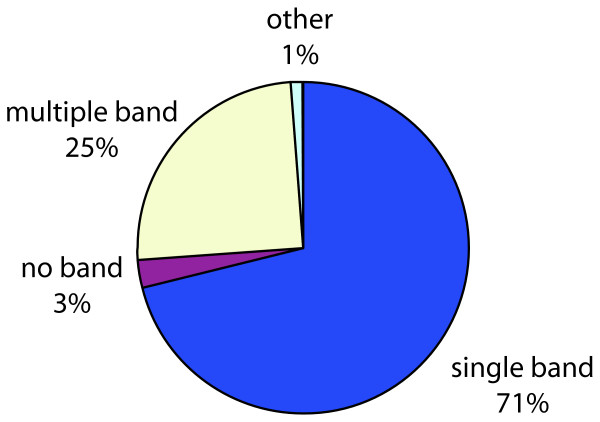
Summary of Western blot results for the first 441 antibodies screened (and currently in AbMiner). The majority of antibodies (71%) produced a single predominant band.